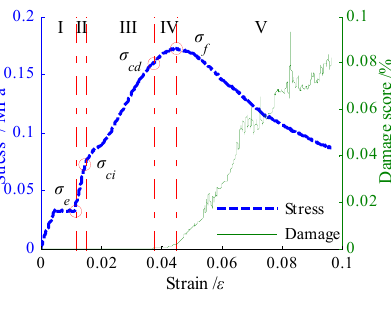
Table 2. Key points of stress and ratios obtained by the fitting-damaging method. Figure 3. Stress-strain curve. Figure 3. Stress-strain curve.